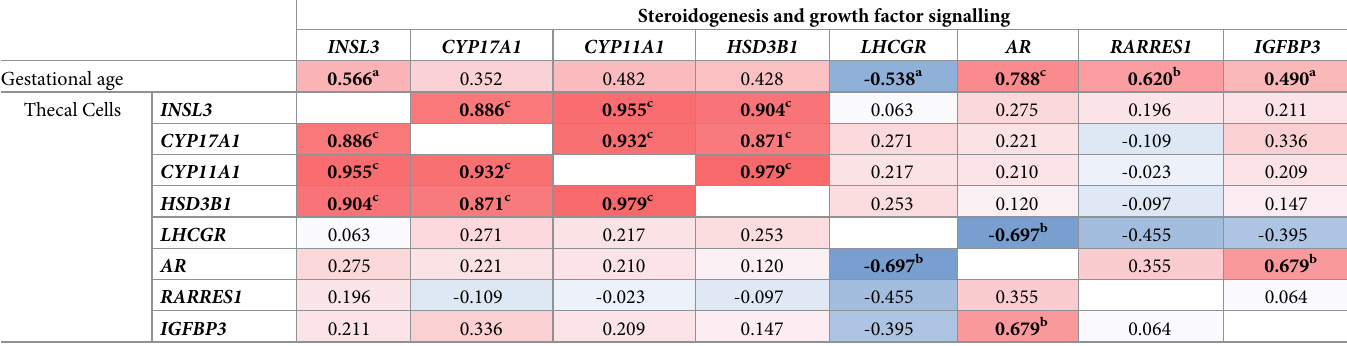
Table 3. Pearson’s correlation coefficients between transcript abundance levels of thecal cells and gestational age. The darker the background colour the more signifi- cant the correlation is. Blue indicates a negative correlation and red indicates a positive correlation. ( P -values: a < 0.05, b < 0.01, c <